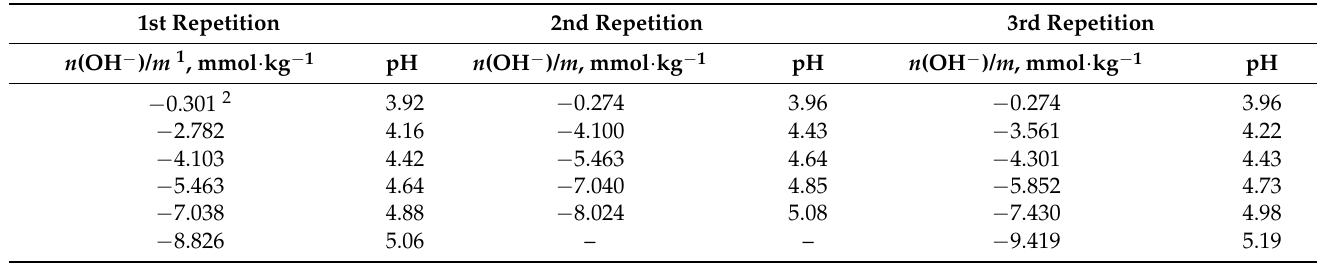
Table 1. Experimental data on titration of water suspensions of the Eg horizon of Eutric Albic Stagnic Retisol (Loamic). 1st Repetition 2nd Repetition